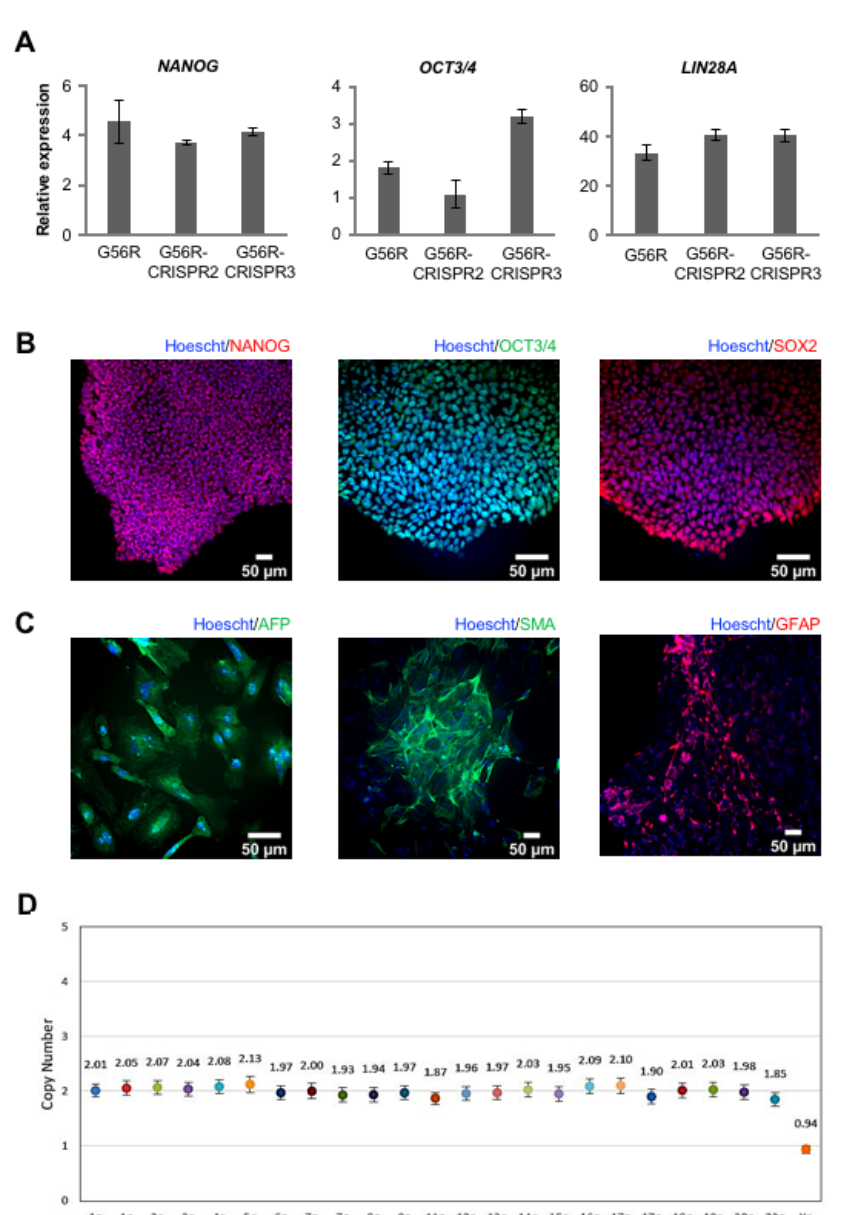
Figure 4. Characterization of the G56R-CRISPR2 and -3 iPSC lines. ( A ) qPCR analysis of the expression of the host pluripotency genes NANOG (left), OCT3/4 (middle), and LIN28A (right) in cDNA from G56R and G56R-CRISPR2 and -3 iPSCs. Results are expressed as mean ± SEM ( n = 3). ( B ) Representative images of IF analysis of the expression of endogenous NANOG (left; G56R- CRISPR3), OCT3/4 (middle; G56R-CRISPR2), and SOX2 (right; G56R-CRISPR2) in G56R-CRISPR2 and -3 iPSCs; nuclei labelled in blue. ( C ) Representative images of IF analysis following embryoid body differentiation of G56R-CRISPR2 and -3 iPSCs for the expression of the germ layer markers AFP (endoderm; left; G56R-CRISPR3), SMA (mesoderm; middle; G56R-CRISPR3), and glial fibrillary acidic protein (GFAP) (ectoderm; right; G56R-CRISPR2). ( D ) Representative digital qPCR analysis of the G56R-CRISPR3 iPSC line for the presence of the most commonly rearranged chromosomal regions detected in iPSCs. A copy number of ~2 for the autosomes, and 1 for the sex chromosomes, is indicative of